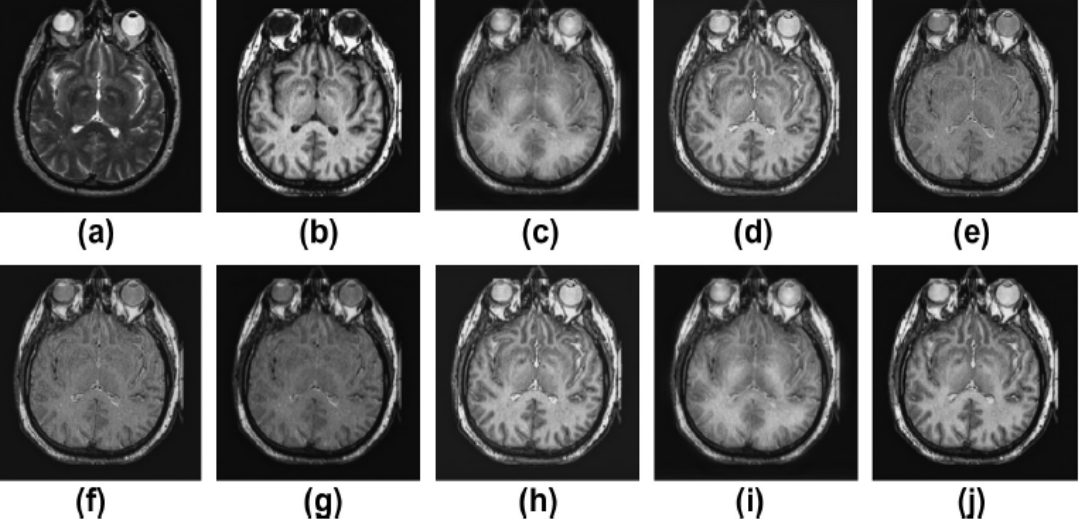
Figure 3. Results of multimodality medical image fusion; ( a ) input multimodality medical image 1;